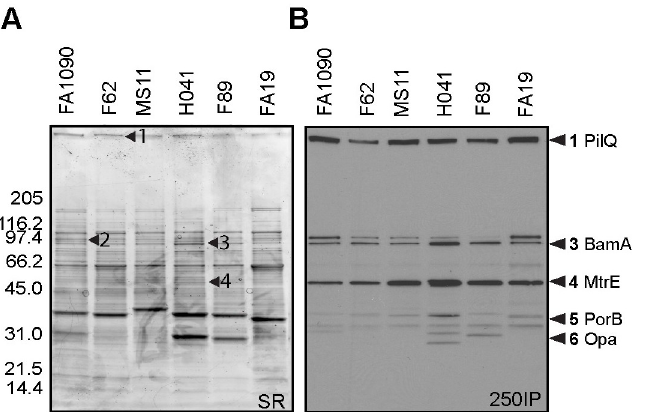
Fig 5. PilQ, MtrE, porin and Opa are recognized by 4CMenB antisera. OMVs (app. 20 μ g) from 6 Ng strains (Table 2) were subjected to SDS-PAGE on a 4–20% Tris-glycine gel and (A) stained with sypro ruby or (B) transferred to PVDF for western blot with the 250IP antiserum. The stained gel was aligned with the Western blot, and corresponding bands were digested and analyzed by mass spectrometry. The numbers indicated with arrows on each panel correspond to the same numbers on the Western blots except for bands 5 and 6, which were excised from a different gel but are indicated on the western based on the banding patterns. Proteins identified are described in Table 1. Among the proteins identified, known surface-exposed outer membrane proteins are: (1) PilQ, (3) BamA, (4) MtrE, (5) PorB, and (6) Opa.